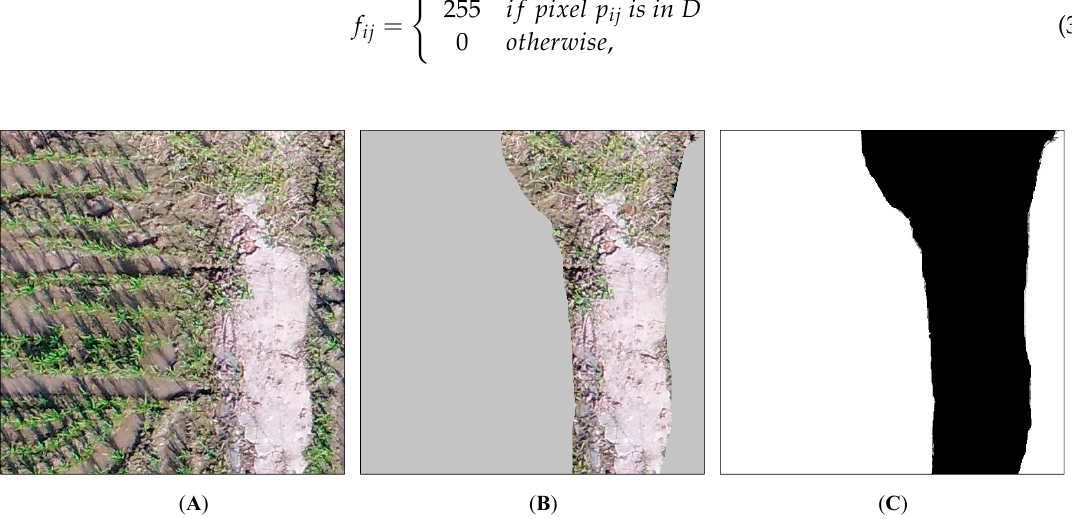
Figure 5. Example of the area of rice seedling annotations: ( A ) cropped UAV image, ( B ) manually-annotated rice seedling area image, and ( C ) its corresponding ground truth binary map. Binary map regression treats the two-dimensional binary map as the regression target in our proposed Segmentation Network.